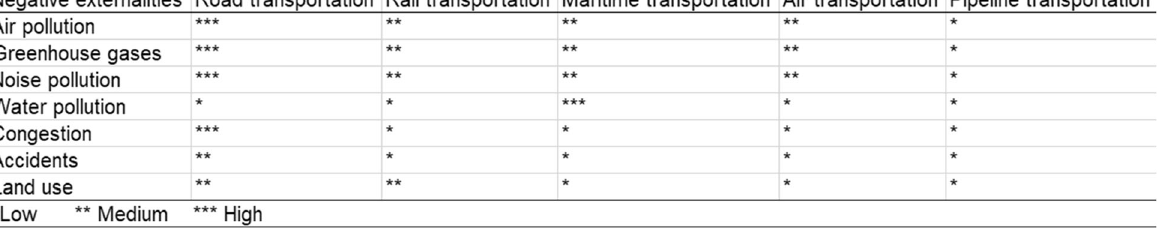
Fig. 1 Relevance of the negative externalities per transport mode